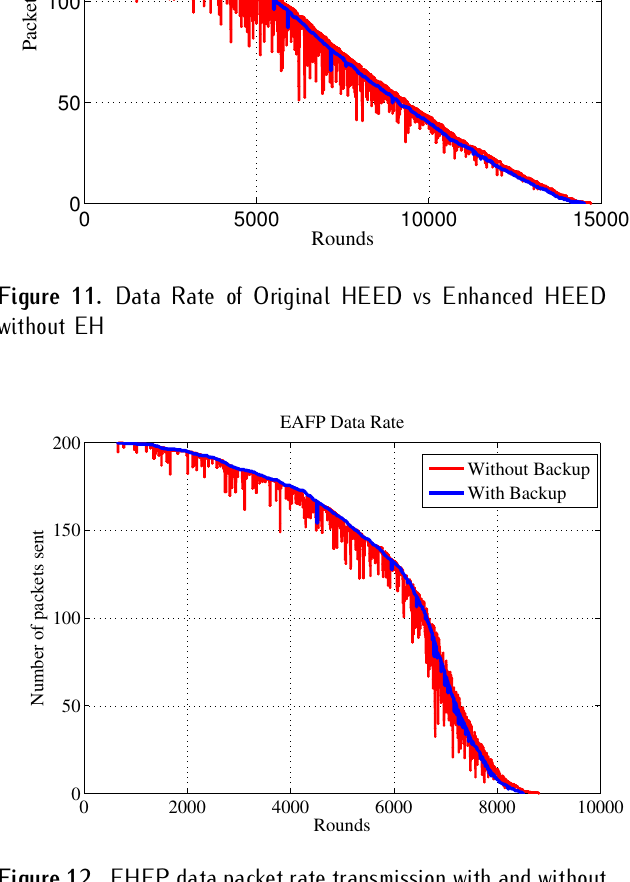
Figure 12. EHFP data packet rate transmission with and without backup